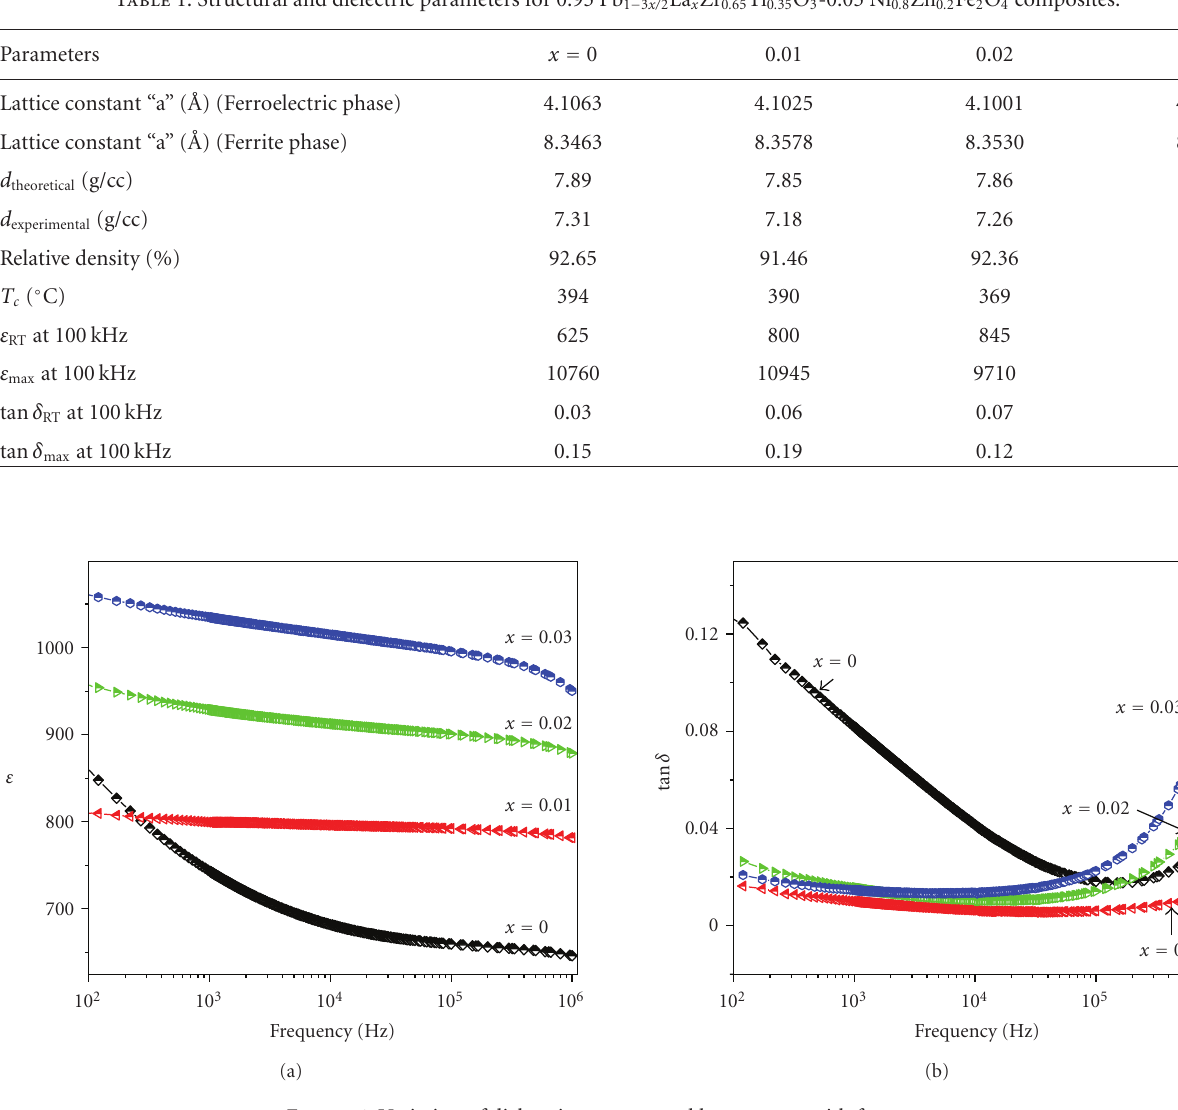
Figure 4: Variation of dielectric constant and loss tangent with